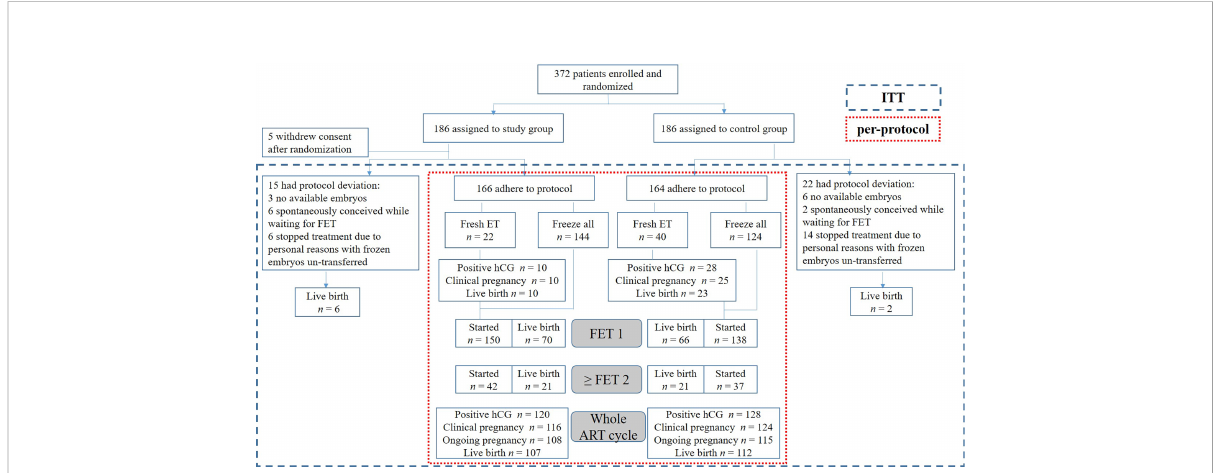
FIGURE 1 Trial fl ow chart. An overview of the study process and cumulative reproductive outcomes in the study and control groups. ITT, intention-to- treat; ET, embryo transfer; FET, frozen embryo transfer; hCG, human chorionic gonadotropin; ART, assisted reproductive